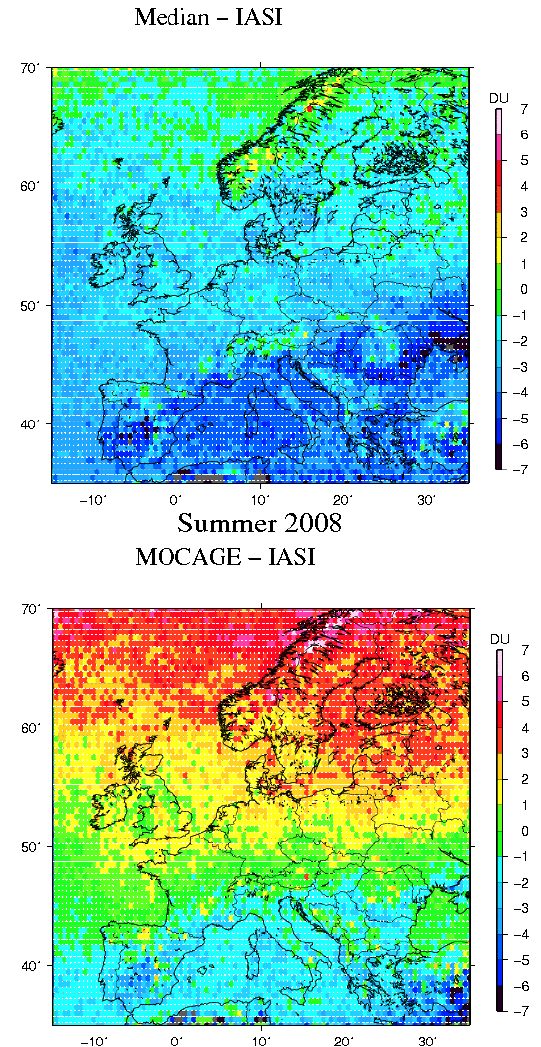
Fig. 6. (a) : Summer 2008 average differences (inDU) between smoothed 0-6km ozone columns: model median minus IASI. (b) : The same as (a) : MOCAGE minus